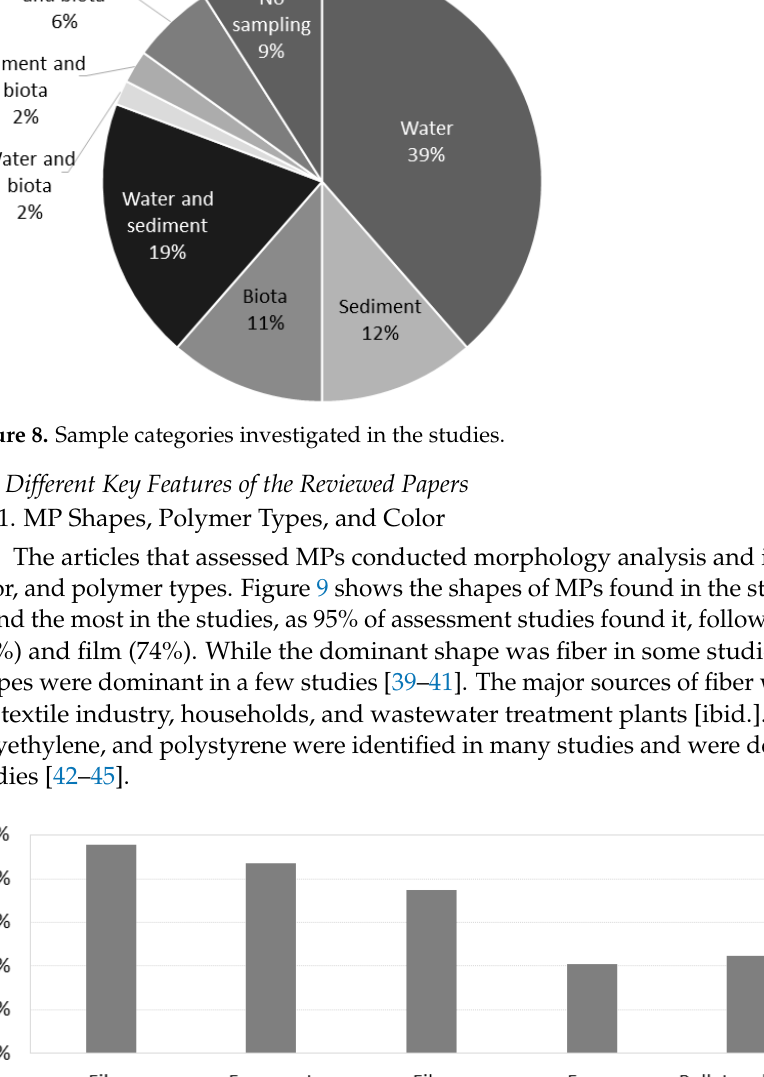
Figure 7. Water systems focused on by the selected studies.